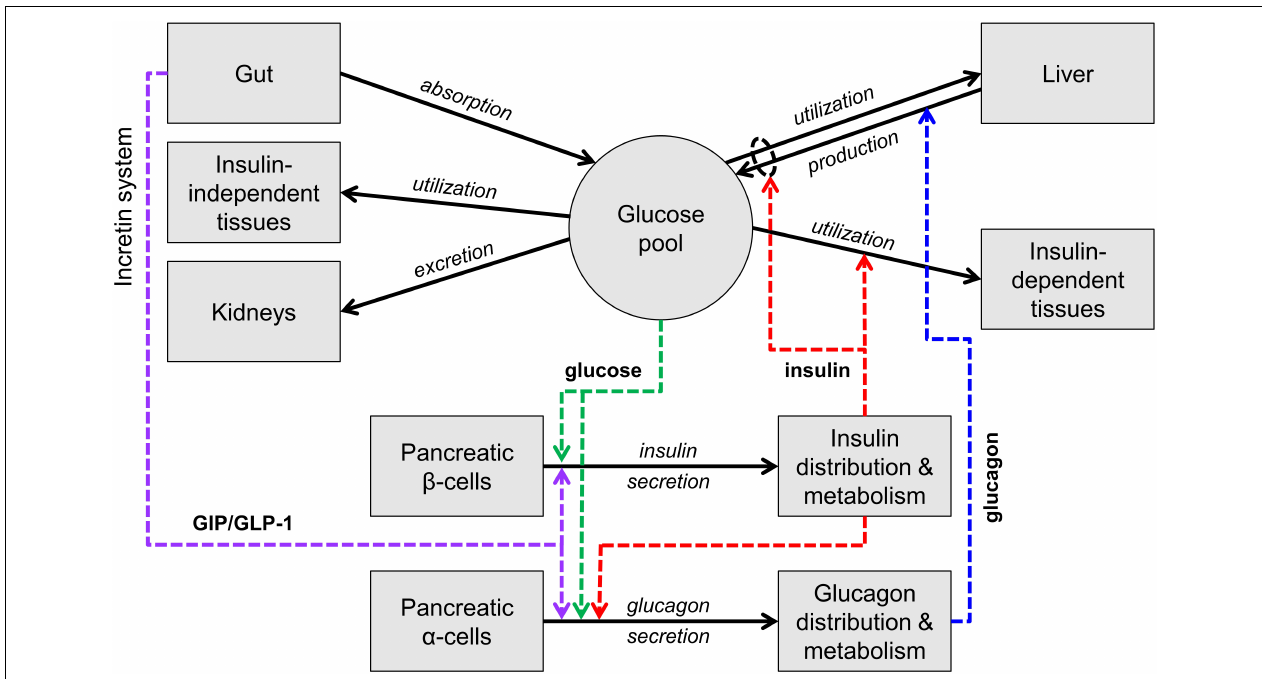
FIGURE 1 | Scheme of the main mechanisms of glucose homeostasis. Mass fluxes are indicated as black solid arrows. Colored dashed arrows represent control signals (glucose or hormone concentrations) that regulate glucose fluxes or insulin and glucagon secretion. The scheme does not show adaptive control mechanisms (e.g., insulin secretion upregulation with insulin